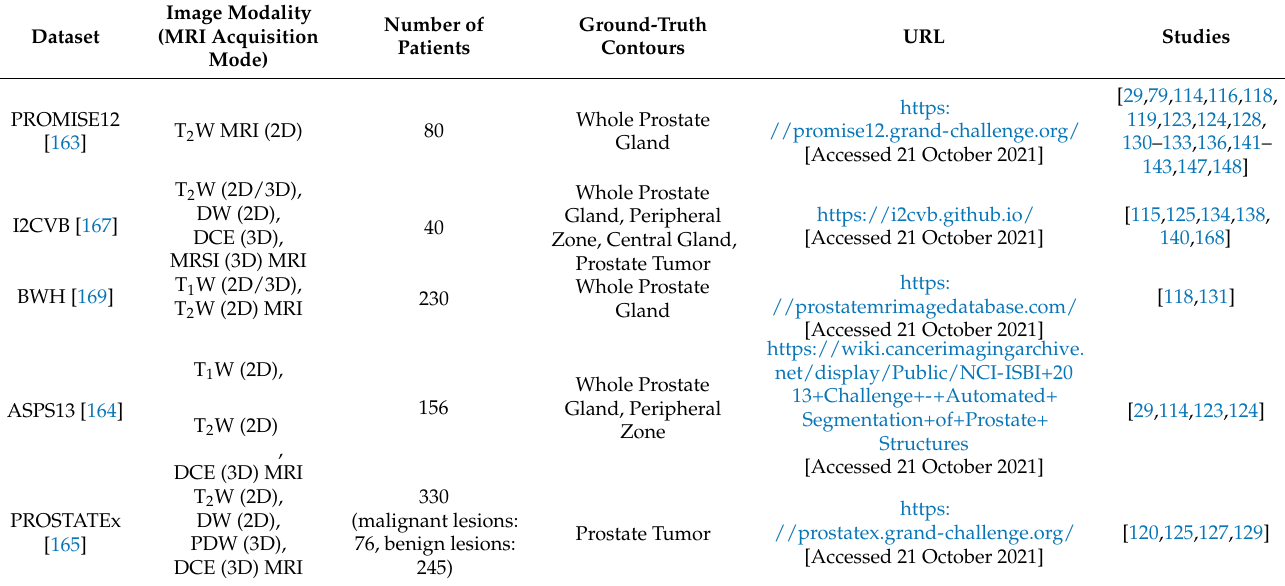
Table 2. Public datasets available for prostate cancer segmentation along with the studies that their results were evaluated on in these databases. T 1 W: T 1 -weighted; T 2 W: T 2 -weighted; DW: Diffusion-weighted; PDW: Proton density-weighted; DCE: Dynamic contrast-enhanced; MRSI: Magnetic resonance spectroscopic